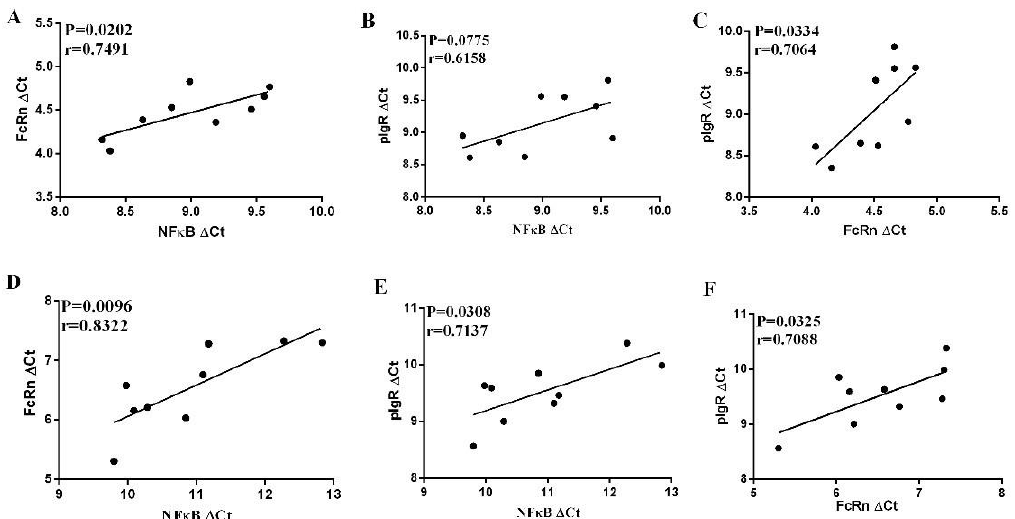
Figure 6. Correlations between the mRNA levels of NF-kB, pIgR and FcRn in the intestinal mucosa of infected piglets. Significant positive correlations were found between NF-kB and FcRn ( A ) and FcRn and pIgR ( B ), but not between NF-kB and pIgR ( C ) in uninfected piglets; however, significant positive correlations were found between NF-kB and FcRn ( D ), FcRn and pIgR ( E ), and NF-kB and pIgR ( F ) in infected piglets. FcRn ∆ Ct = Ct FcRn − Ct GAPDH , NF-kB ∆ Ct = Ct NF-kB – Ct GAPDH , pIgR ∆ Ct = Ct pIgR – Ct GAPDH .